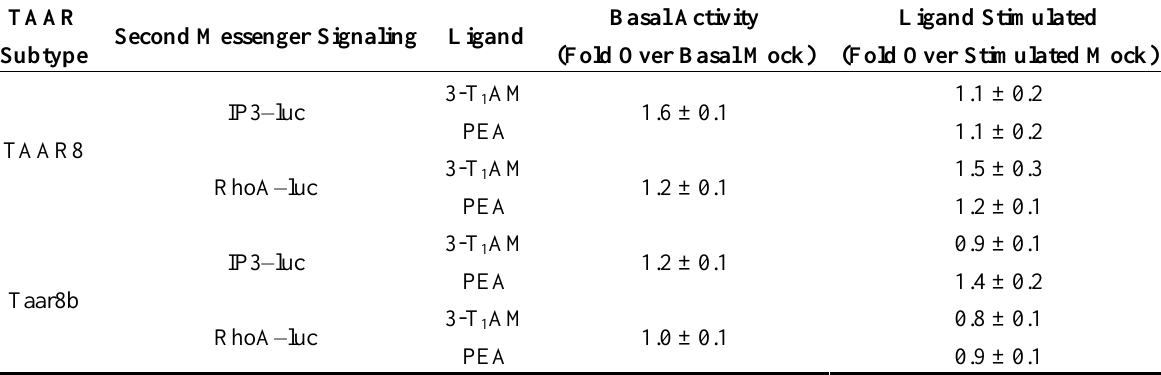
Table 1. Basal signaling activity and stimulation of G q/11 and G 12/13 pathways with 3-T 1 AM and PEA at TAAR8 and Taar8b. Cells over-expressing TAAR8 and Taar8b were stimulated with either 10 µM 3-T 1 AM or 10 µM PEA. Values represent luciferase activities (IP3–luc, RhoA–luc) and are indicated as mean ± SEM relative light units (rlu) in fold over basal or ligand-stimulated mock, each based on three to five independent experiments performed in triplicate. Mock transfected cells showed basal levels of 5003 ± 930 rlu for IP3-luc and 209,855 ± 27,087 rlu for RhoA-luc. The human thyrotropin receptor (TSHR) served as a positive control. Cells transfected with TSHR demonstrated basal levels of 3442 ± 589 rlu (IP3–luc) or 435,437 ± 70,197 rlu (RhoA–luc). Stimulation of TSHR was found to be within a range of 64.4 ± 13.0 rlu (IP3–luc) or 17.4 ± 4.7 rlu (RhoA–luc) fold over basal